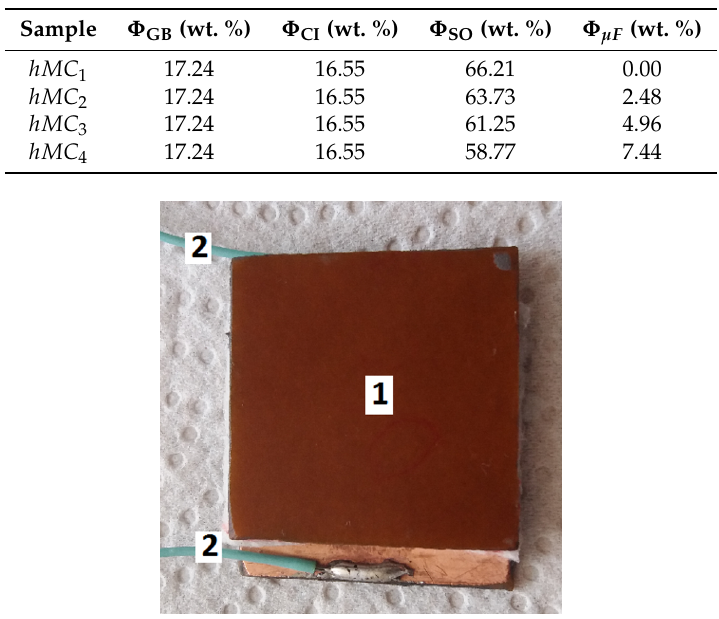
Figure 3. Electrical device (plane capacitor) with hMCs as dielectric material. Textolite plate (view of the side not covered with copper)—position 1; Electrical conductors—position